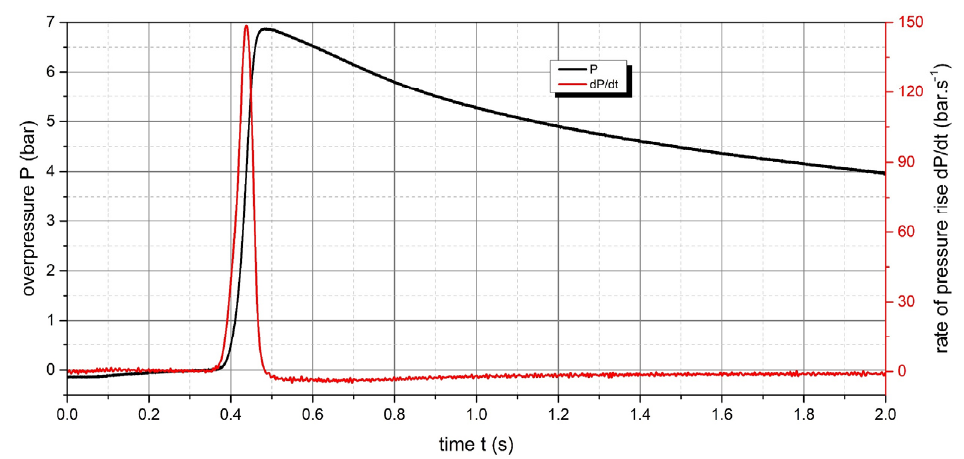
Figure 8. Overpressure P and rate of pressure rise dP/dt of 500 g·m − 3 Lycopodium clavatum powder ignited by Igniter 1 (shelf life less than 1 year).